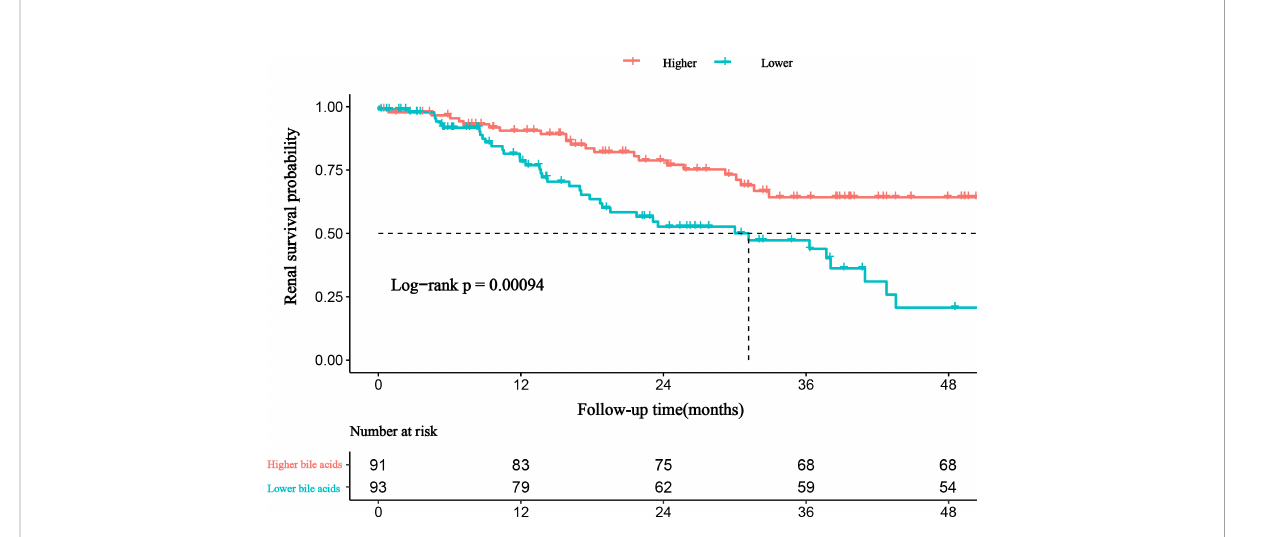
FIGURE 4 The prediction of bile acids for ESRD in DKD